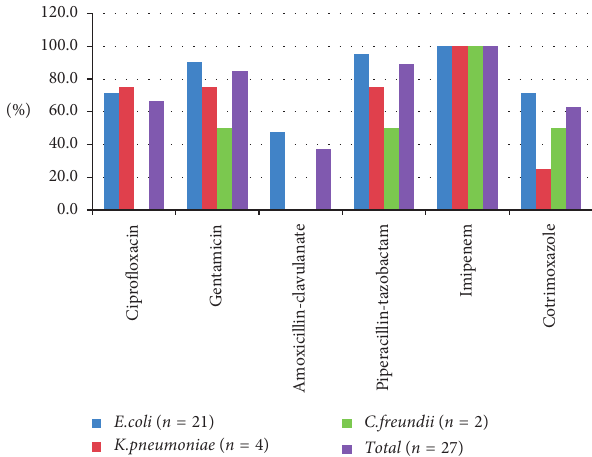
Figure 2: Antimicrobial susceptibility of ESBL-producing strains ( n � 27) in healthy